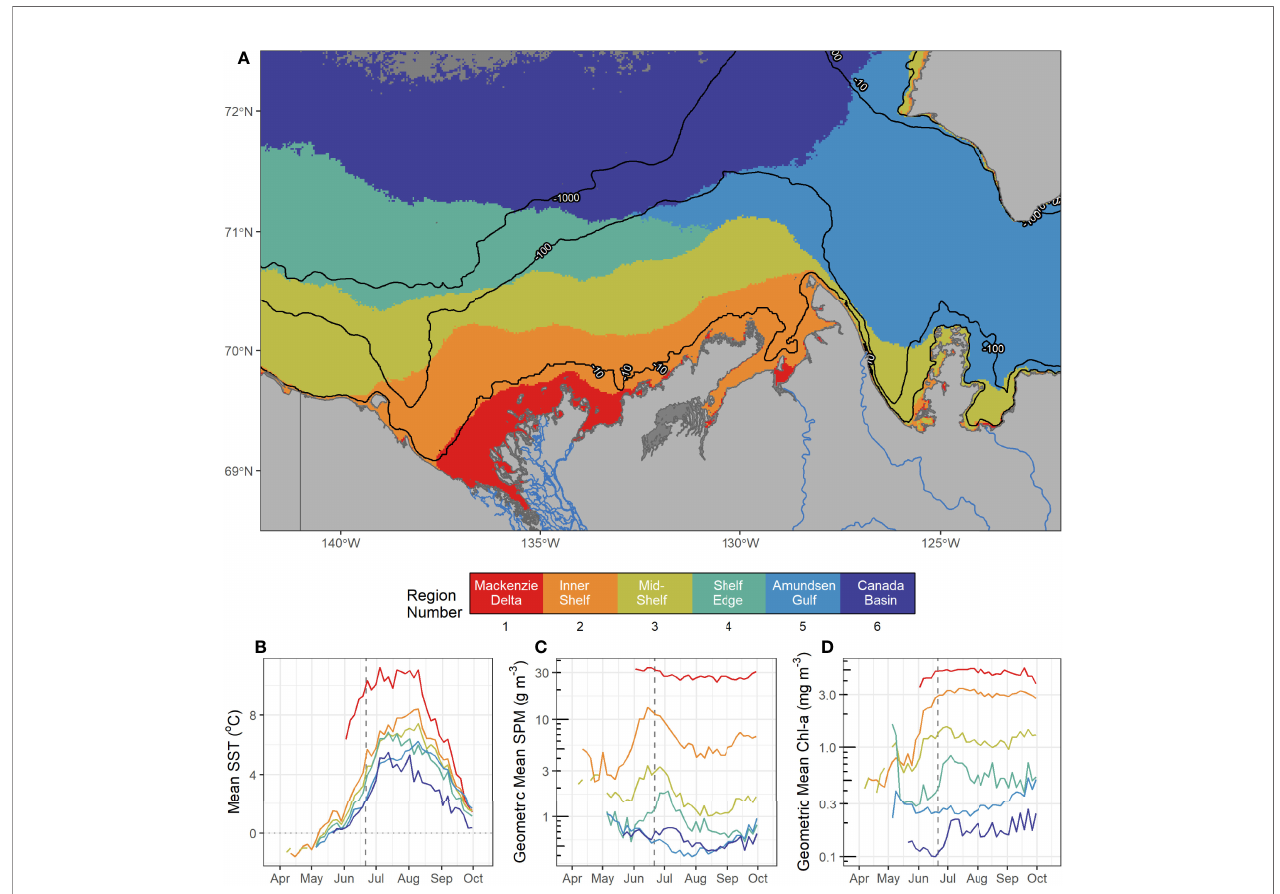
FIGURE 4 | Six biogeochemical regions de fi ned by the SOM analysis of satellite SST, SPM and Chl-a for the period 2003 – 2019 (A) . The solid black lines correspond to the 10-m, 100-m and 1000-m bathymetric contours. The middle inset indicates the biogeochemical region and its name. The four-day climatologies of SST (B) , SPM (C) and Chl-a (D) are presented for each region with the grey dashed line indicating the date of the summer solstice (i.e., June 21 st ). Ocean pixels indicated in grey did not contain enough data and were not included in the